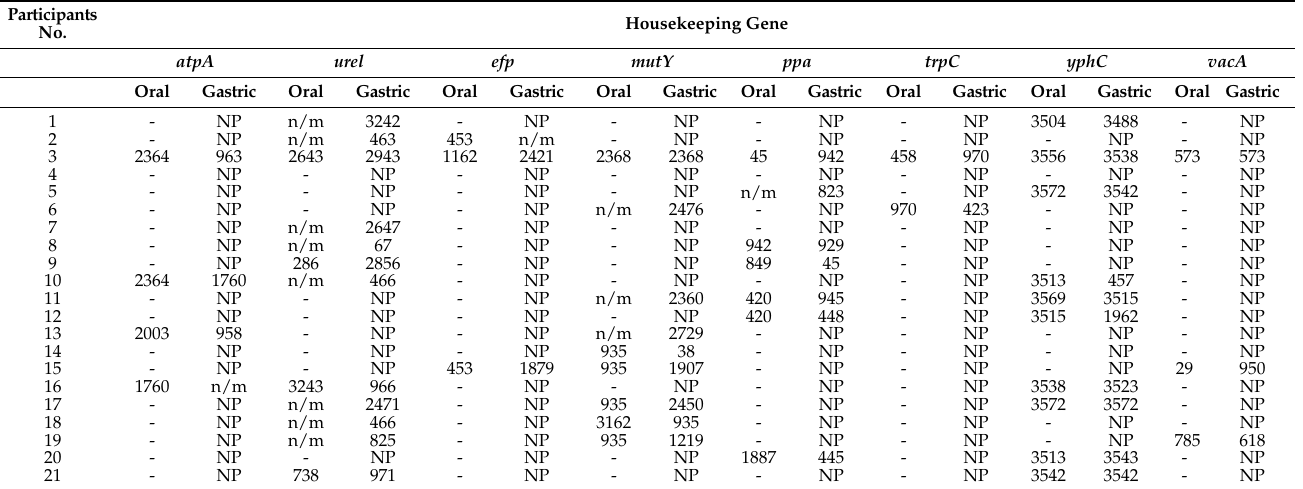
Table 3 compares the H. pylori allelic profiles obtained from oral and gastric samples based on eight housekeeping genes. The number of H. pylori allelic profiles ranged from zero to eight since the yield of DNA was small even when the nested PCR was performed. The alleles of eight loci from both collection sites were determined from only one patient (patient no. 3), and two out of eight alleles matched between oral and gastric samples. Moreover, for one sample set (patient no. 4), no amplification was observed for any of the eight housekeeping genes, and therefore, no allele analysis was performed for the sample set. For the rest, allele analysis was performed on the obtained sequences to determine the allele number, of which some were novel and, therefore, unclassified. Table 3. Allele analysis of H. pylori DNA sequences obtained from oral and gastric samples targeting eight housekeeping